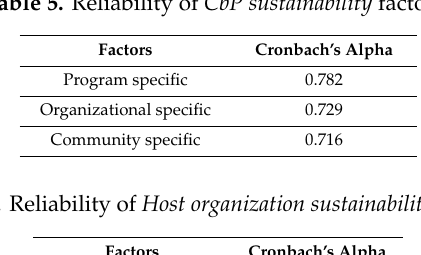
Table 5. Reliability of CbP sustainability factors.